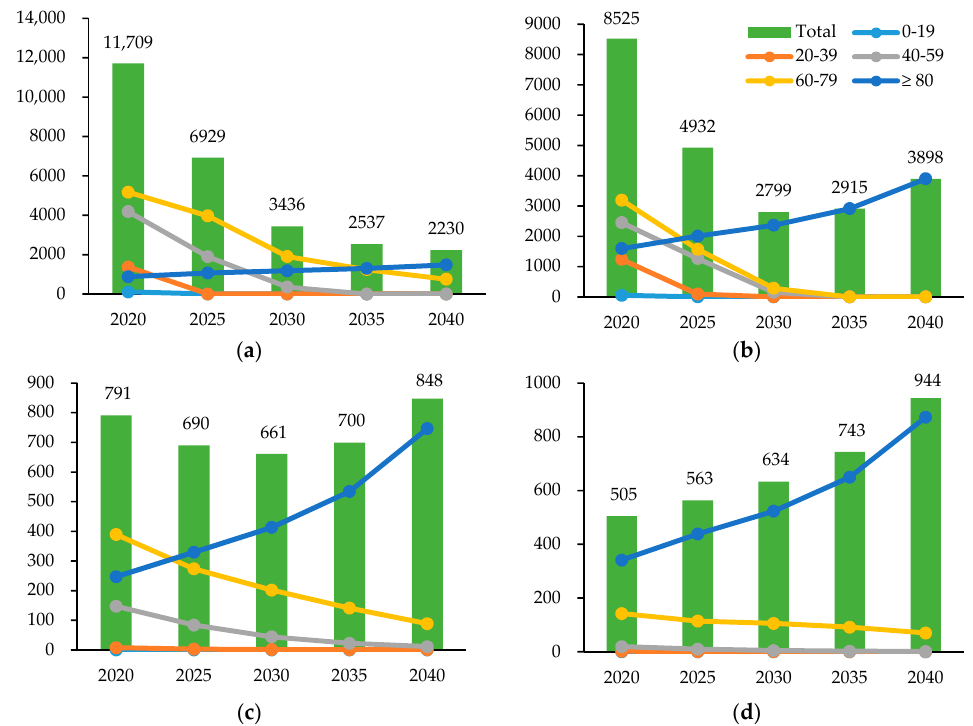
Figure 3. Projected number of new tuberculosis cases and deaths caused by tuberculosis in Korea by sex and age group, 2020–2040. ( a ) The projected number of new tuberculosis cases in males, by age group. ( b ) The projected number of new tuberculosis cases in females, by age group. ( c ) The projected number of deaths caused by tuberculosis in males, by age group. ( d ) The projected number of deaths caused by tuberculosis in females, by age group.